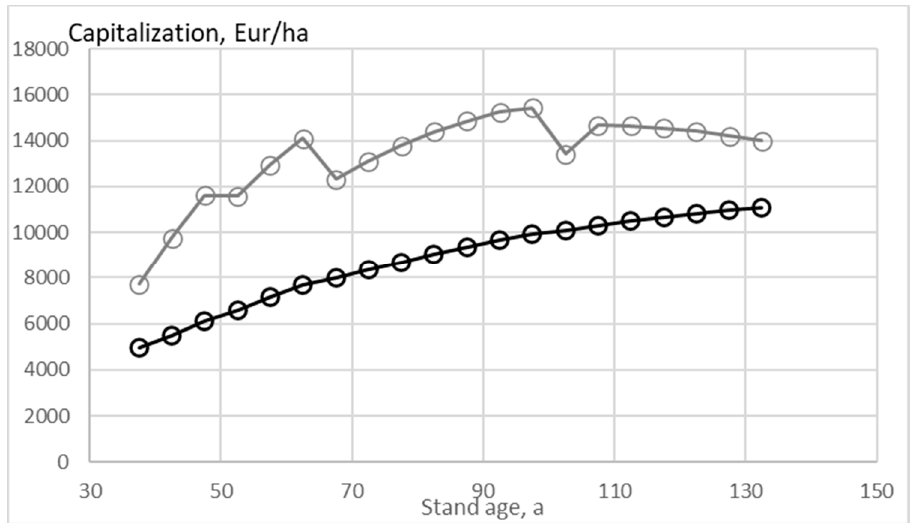
Figure 11. Capitalization per hectare (thin drawing) and expected values accumulated over stand age (thick drawing), with thinnings from below.